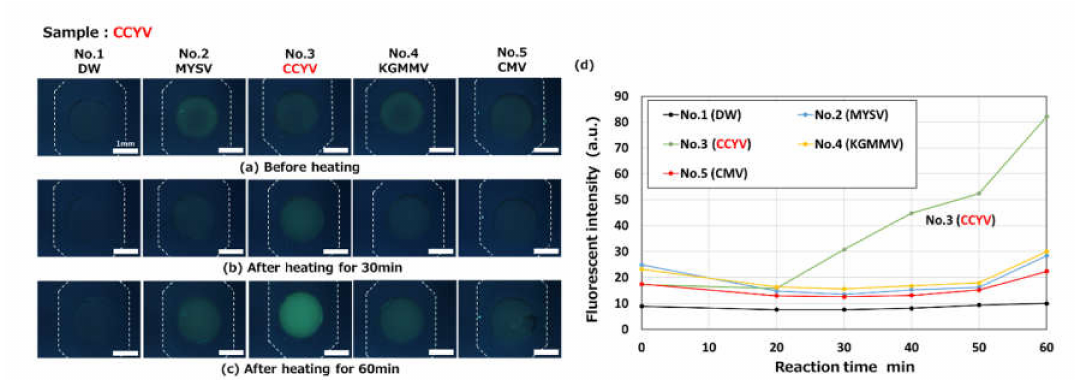
Figure 16. Fluorescence microscopy images showing the RT-LAMP detection of an RNA-based plant virus (cucurbit chlorotic yellows virus, CCYV) observed ( a ) before heating and after heating for ( b ) 30 min and ( c ) 60 min at 63 ◦ C (taken with an optical filter BV-2A, gain: 1 × , exposure time: 2 s). A primer set for the detection of CCYV was pre-spotted in a reaction chamber (No. 3). ( d ) Changes in fluorescence intensities as a function of the reaction time. The concentration of total RNA, containing the CCYV viral RNA target, was 19.3 ng / µ L after mixing with the LAMP